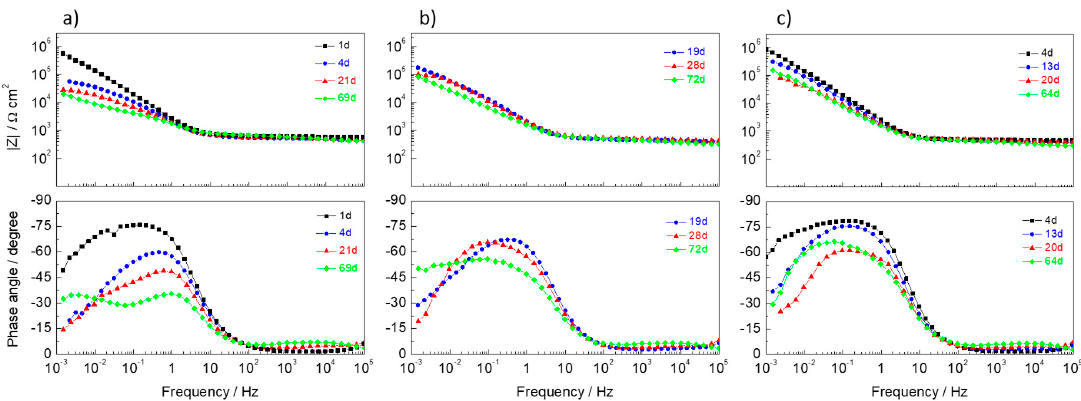
Figure 8. Impedance response of mortars with steel bar immersed in 3.5% NaCl: ( a ) Mortar without LDH (reference), ( b ) mortar with 0.3% ZnAl-NO 3 (2% with respect to cement), ( c ) mortar with 0.3% ZnAl-NO 2 (2% with respect to cement).